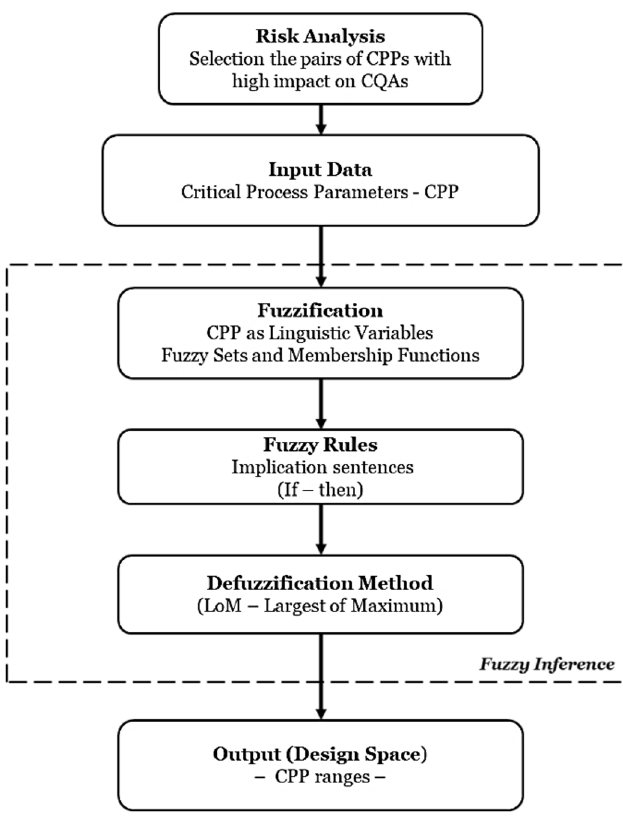
Fig. 5. Fuzzy inference steps for developing the Design Space.